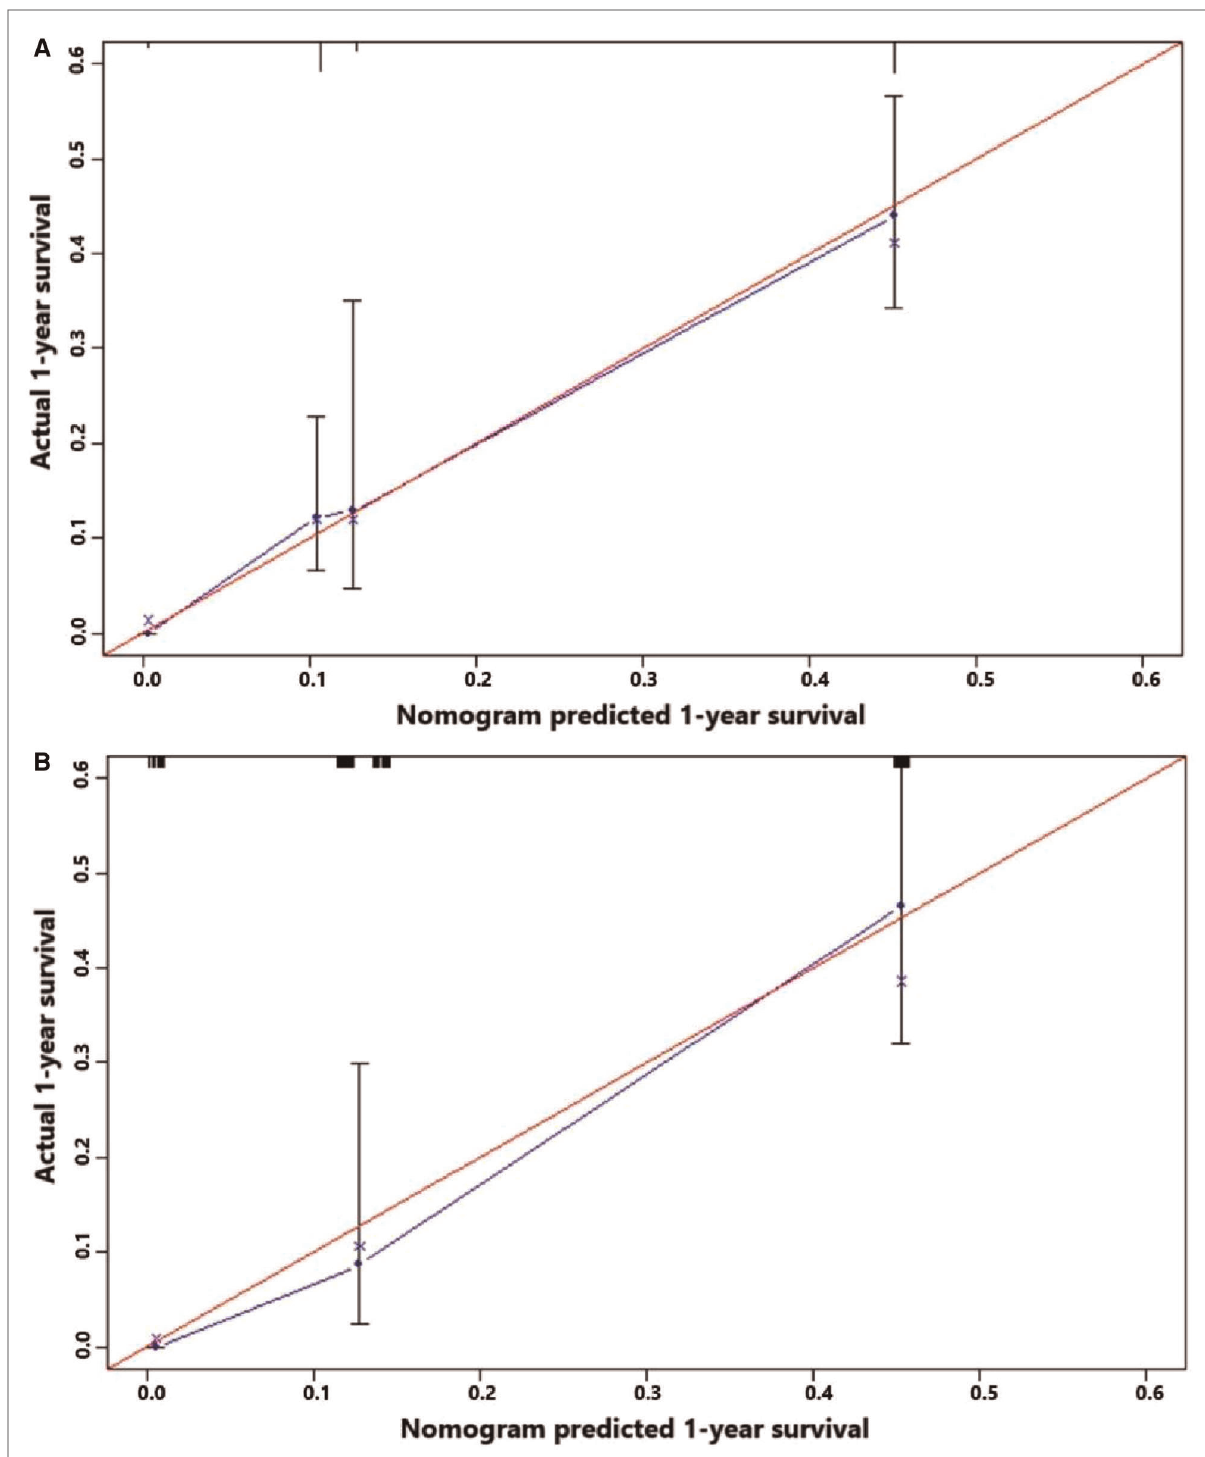
FIGURE 8 ( A ) Calibration curve of the constructed nomogram for predicting 3-year survival of gallbladder cancer patients with liver metastasis in the training cohort. ( B ) Calibration curve of the constructed nomogram for predicting 3-year survival of gallbladder cancer patients with liver metastasis in the testing